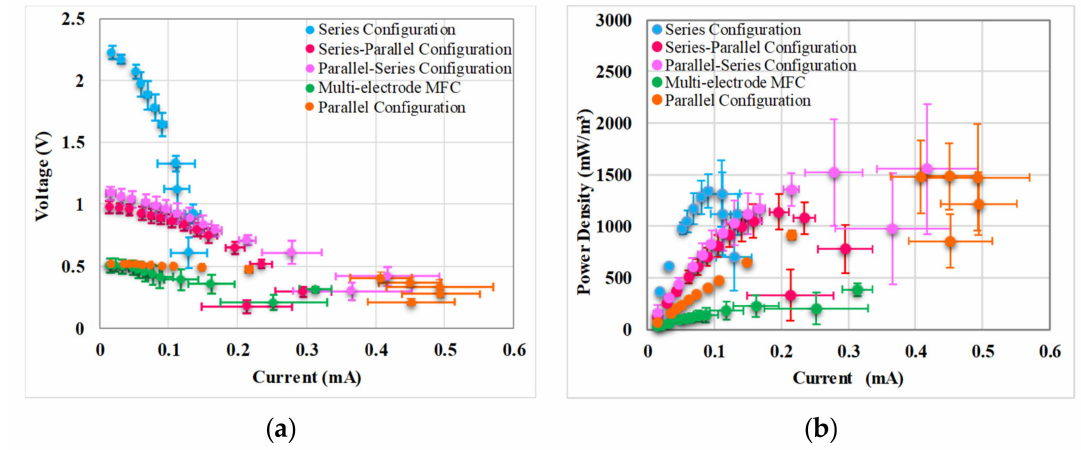
Figure 10. Test 1 results: polarization curves ( a ) and volumetric power density curves ( b ). The calculated standard deviations of the maximum power densities are equal to ± 323.04, ± 514.53, ± 170.74, ± 633.05, and ± 88.63 for the series, parallel, series/parallel, parallel/series, and multi-electrode configurations,